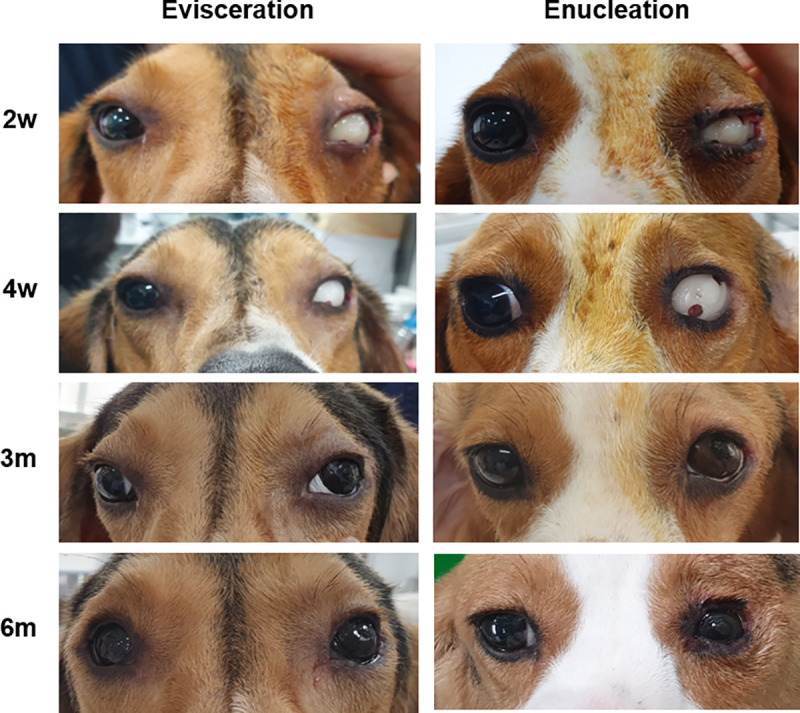
Postoperative gross findings 2 and 4 weeks after applying ocular conformer (A and B, respectively) in eviscerated or enucleated dogs. Six weeks after surgery, the conformer was removed, and prosthesis was applied (C). The appearance of the dog wearing prosthesis was good to excellent after more than six months.